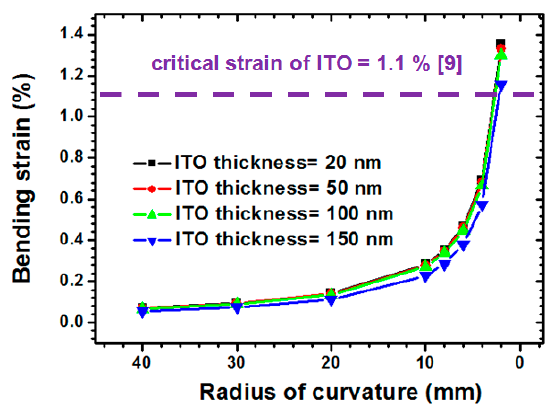
Figure 9. Thickness effect of ITO film coated on PET substrate on induced ITO bending strain estimation.